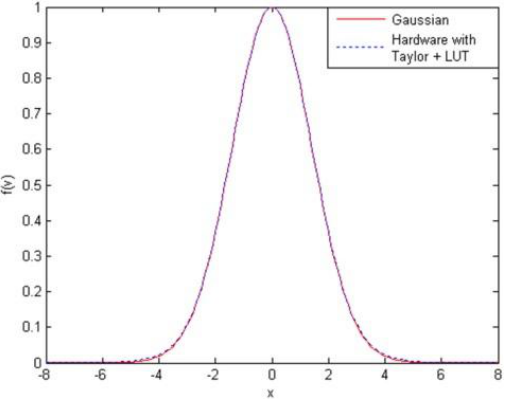
Figure 10. Taylor and LUT approximation of a Gaussian function.